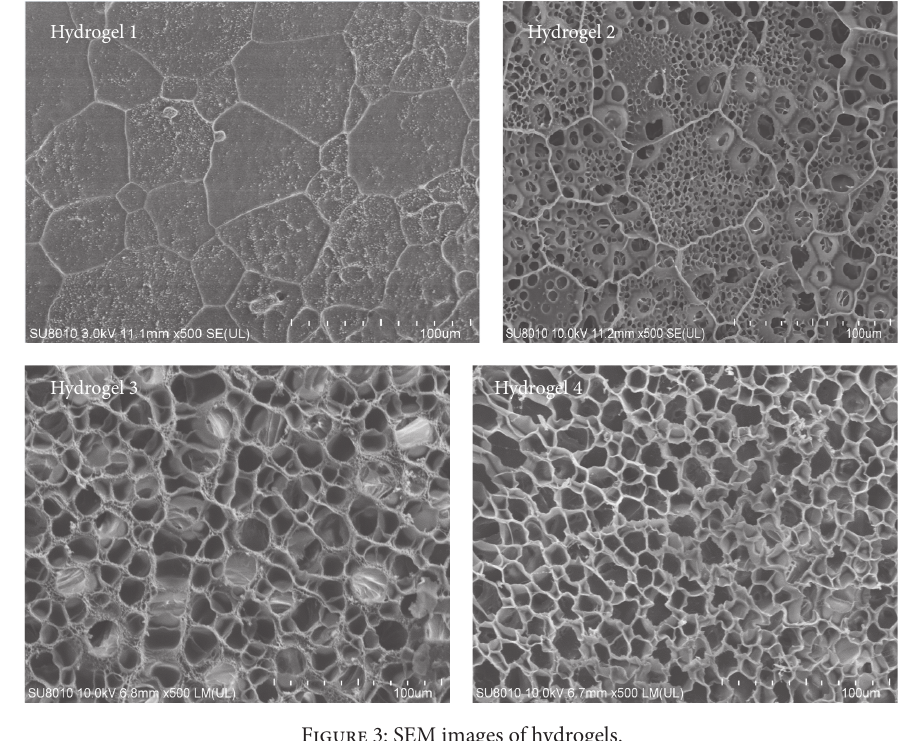
Figure 3: SEM images of hydrogels.